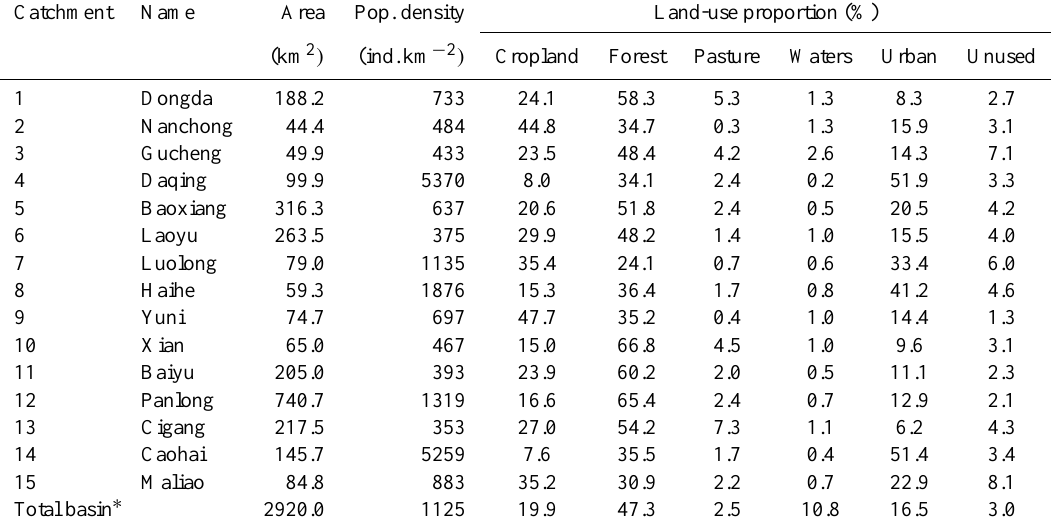
Table 1. Summary of catchment data on area, population and land use. Catchments 12 (Panlong), 5 (Baoxiang), and 6 (Laoyu) are the three biggest catchments in the Lake Dianchi basin, accounting for 45.2% of the total basin area. Collectively, catchments 4 (Daqing), 12 (Panlong), and 14 (Caohai) comprised 69.4% of the total population. There is great variety in natural and social